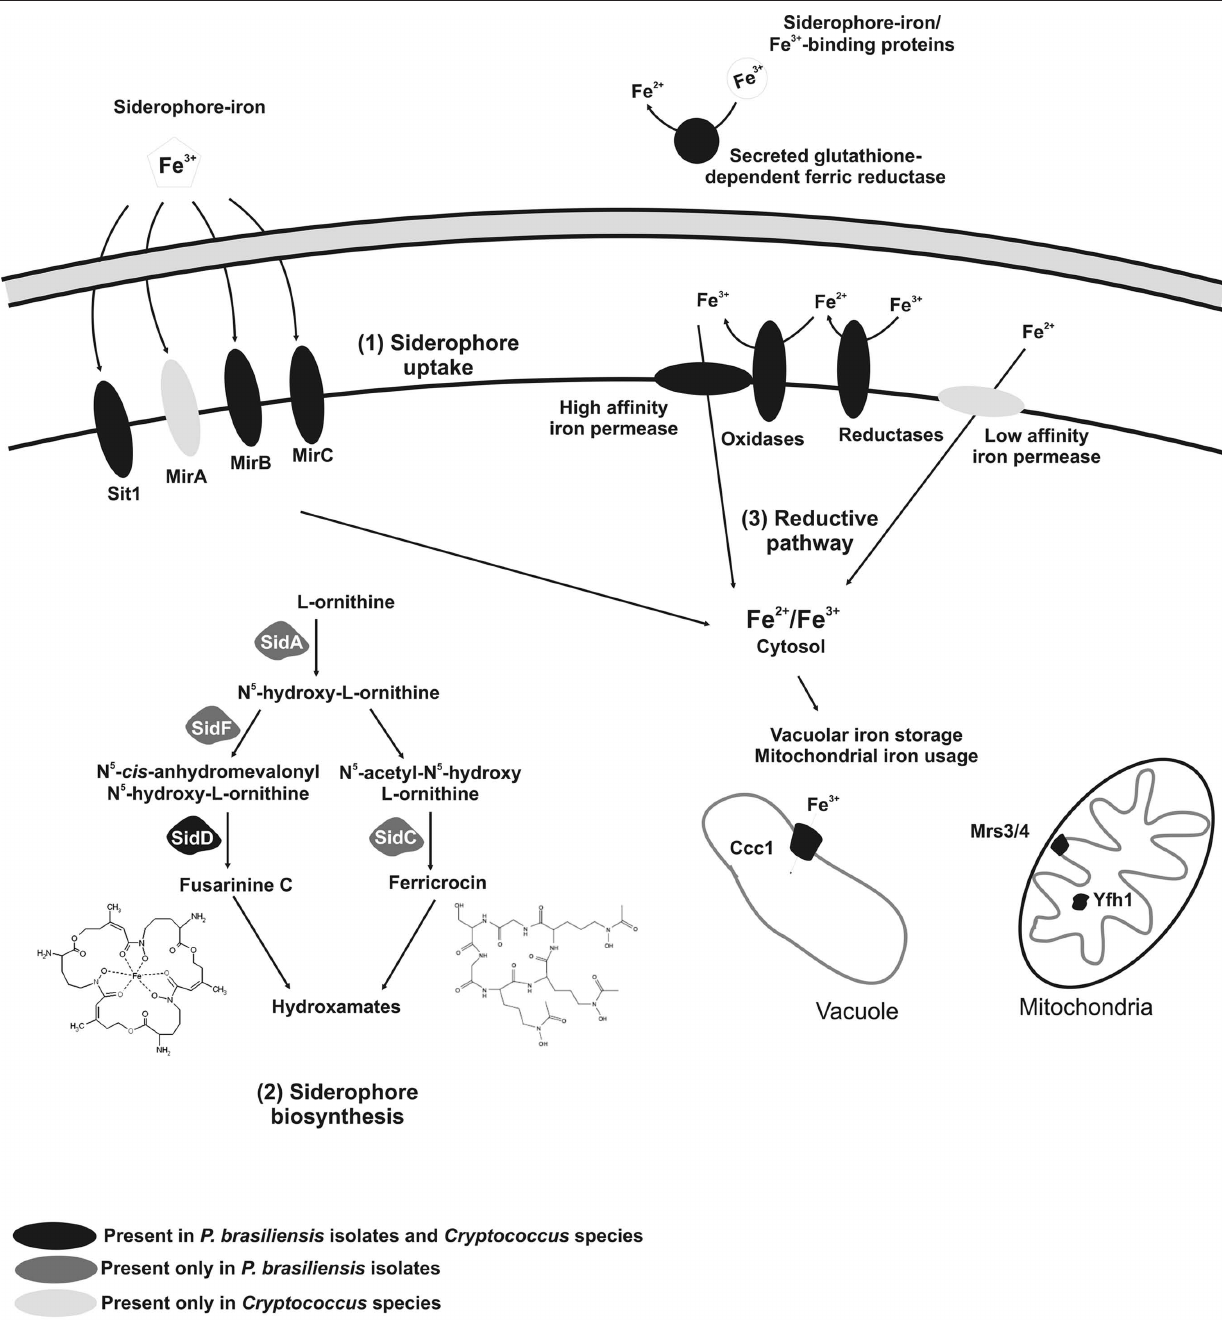
FiGure 1 | Schematic comparison of iron metabolism in P. brasiliensis isolates and Cryptococcus species. Sit1p, MirAp, MirBp and MirCp are membrane transporters that traffic siderophores bound to ferric iron into the intracellular environment. SidAp, SidFp, SidCp and SidDp are enzymes from